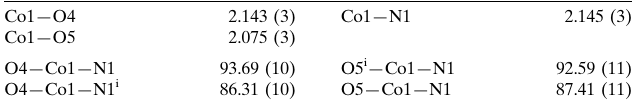
Selected geometric parameters (A˚ , (cid:1)